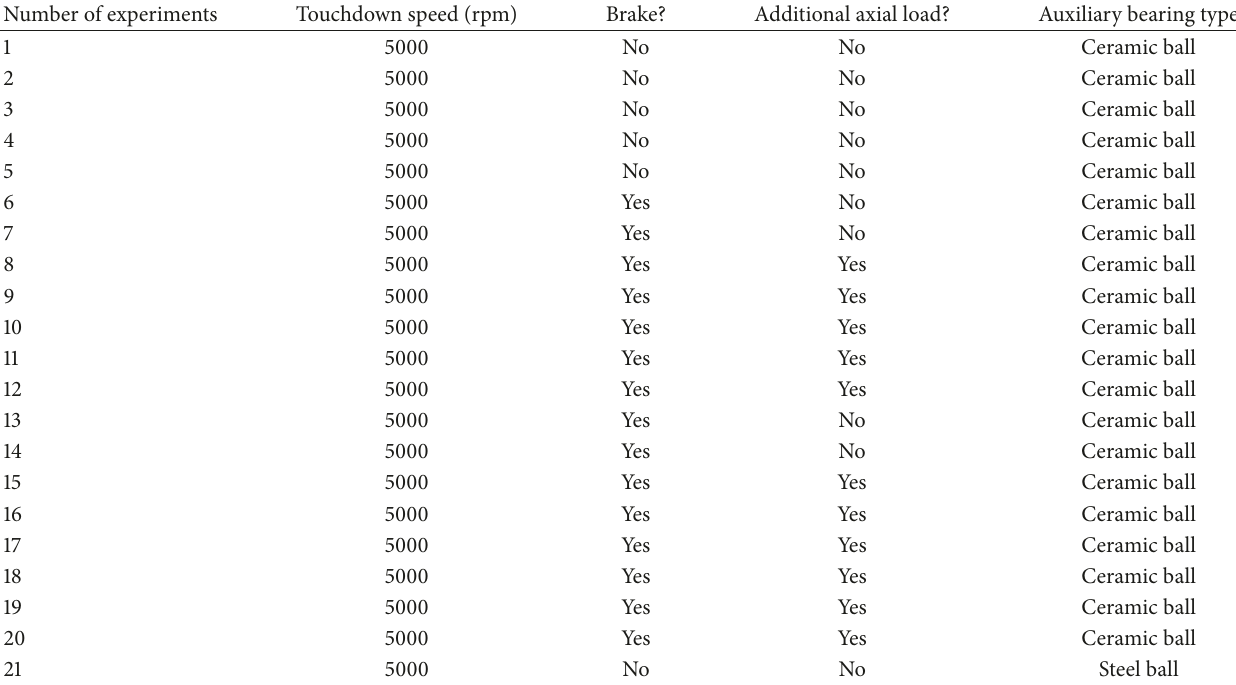
Table 1: Summation of touchdown experiments.